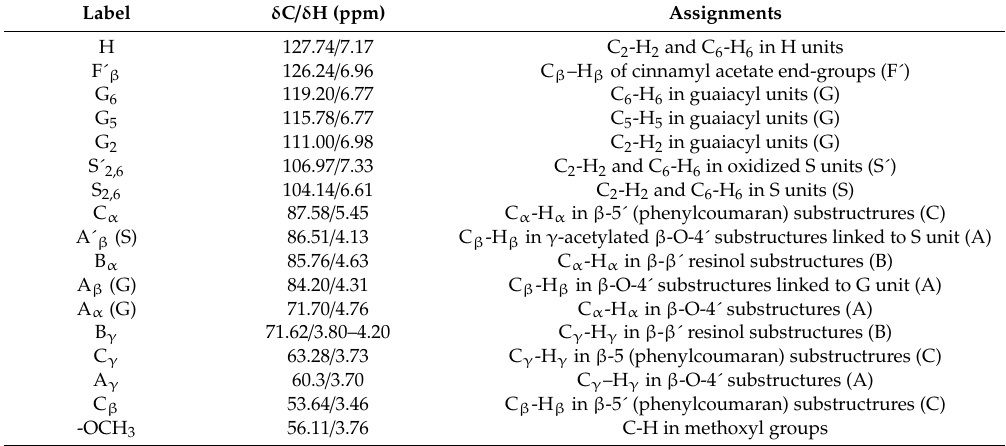
Table 3. Assignments of 13 C- 1 H cross signals in the HSQC spectra shown in Figure